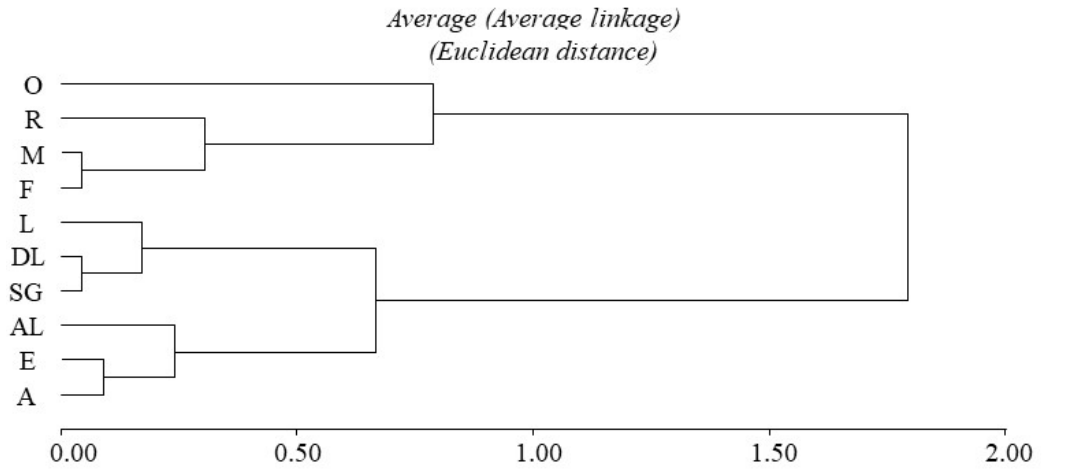
Figure 5. Cluster analysis for the ODBA variance values associated with the behaviours of adult Tamandua tetradactyla (n = 5 females and 5 males) exposed to test in the experimental room. The hierarchical sequence of cluster formation was produced taking into account the average comparison. Abbreviations: O: others; R: resting; M: motionless; F: feeding; L: locomotion; DL: descent locomotion; SG: self-grooming; AL: ascendent locomotion; E: exploration; and A: alert.